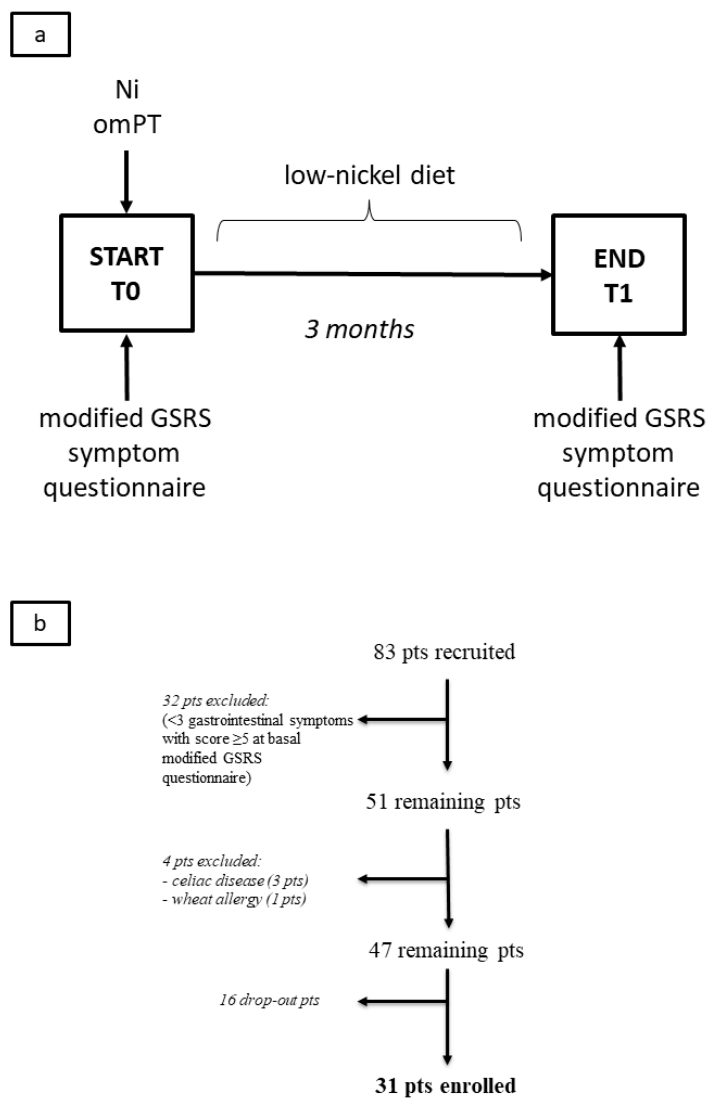
Figure 1. Flow charts of the study: ( a ) Study arrangement, ( b ) patient enrollment. Legend: Ni omPT , nickel oral mucosa patch test; pts , patients; T0 , baseline; T1 , after three months.